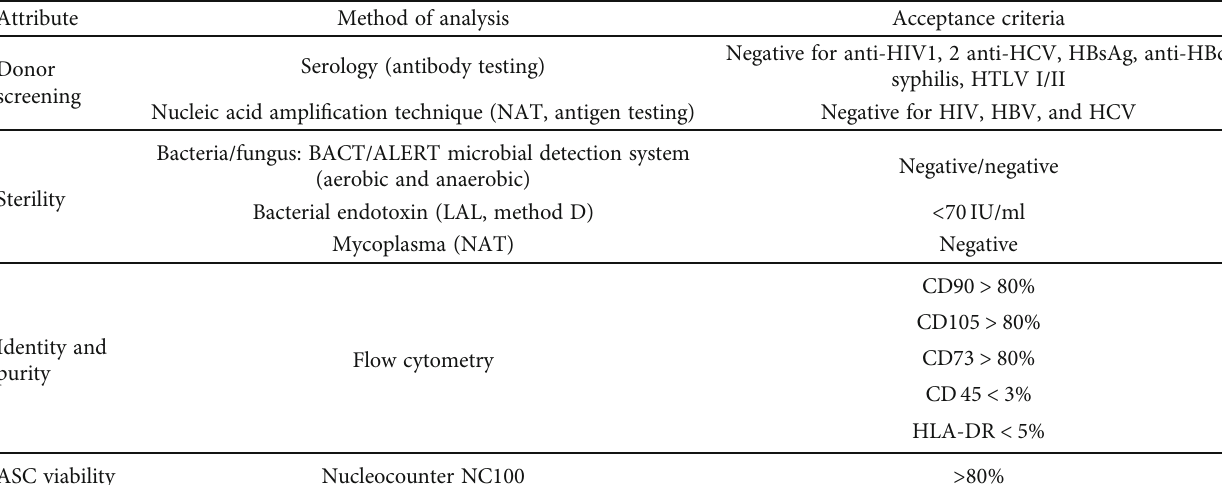
Table 2: Release